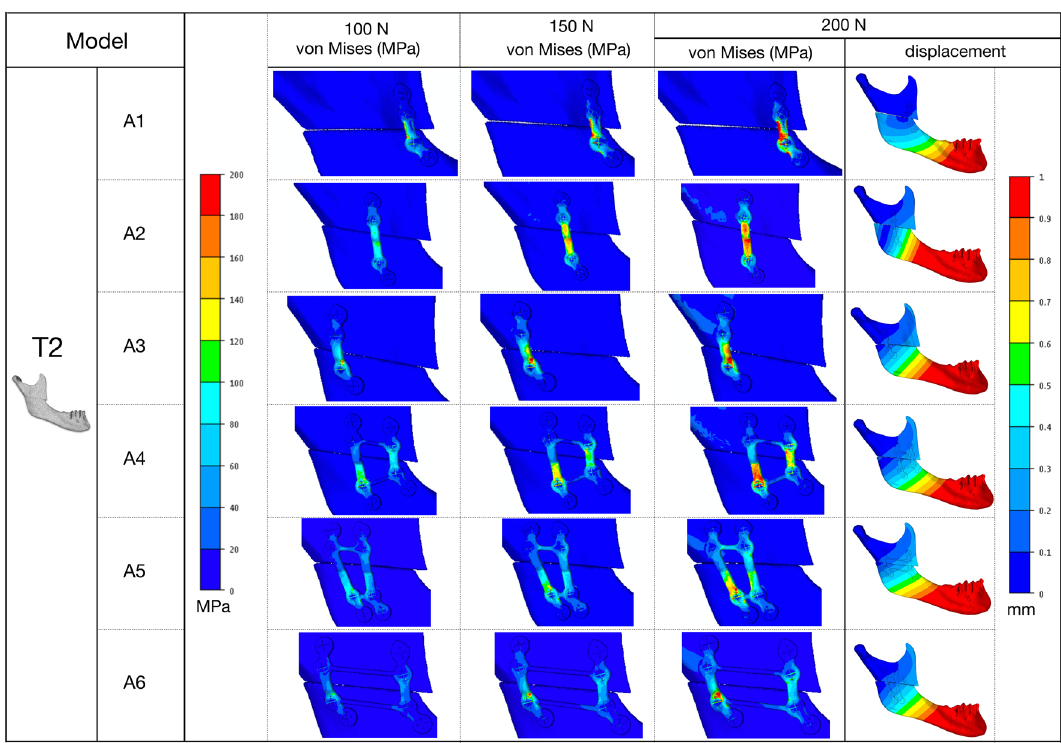
Figure 6. von Mises stress distribution in fixation schemes and the displacement shift between the proximal and distal bone segments in the T2